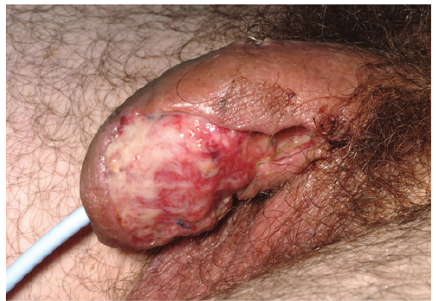
Figure 2: Left lateral view of penis following debridement.